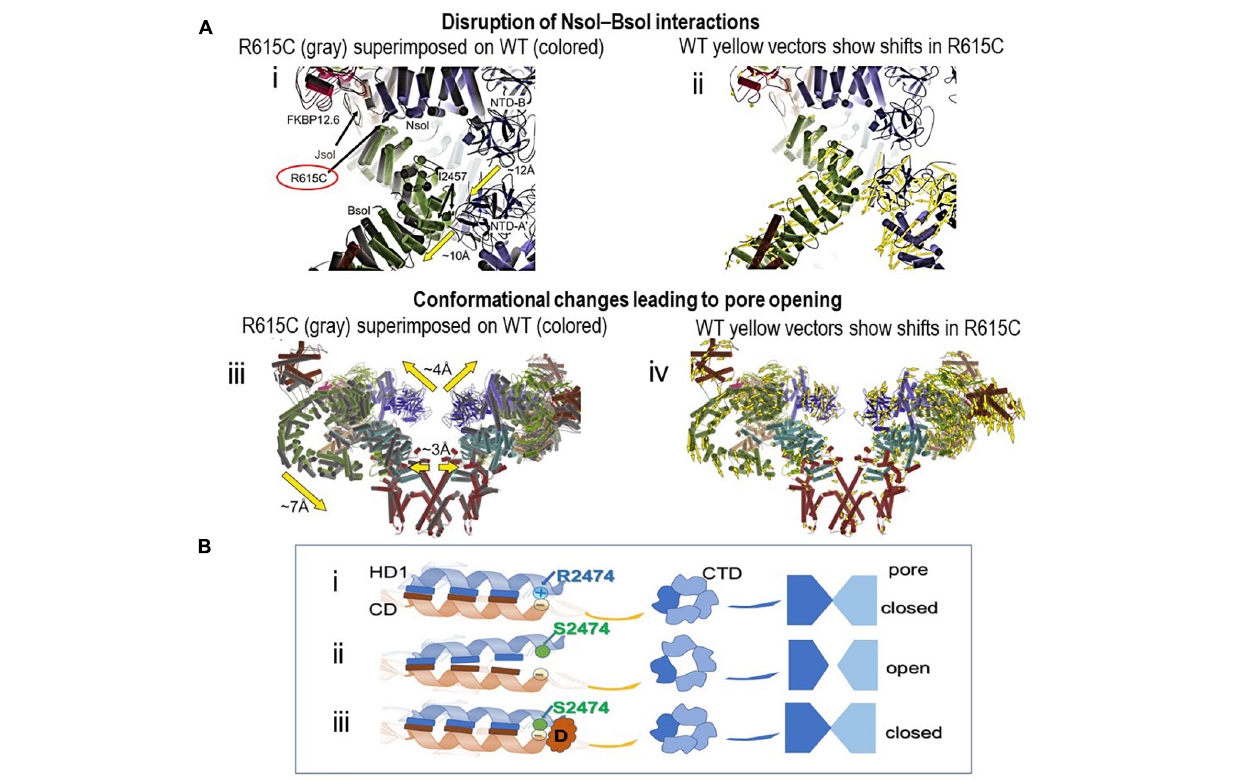
FIGURE 2 | Structural changes associated with RyR mutations. (A) CryoEM images showing that the R615C mutation induces RyR1 channel opening by disrupting interactions between the Nsol and Bsol regions. (i,ii) show local changes around R615 as a result of the mutation, while (iii,iv) illustrate the resulting global changes in the protein. Alpha helices are represented as cylinders. (i) WT (colored) and R615C (gray) structures are superimposed, based on the Nsol region. The location of residue 615 is shown at the junction between the three solenoid regions, the N-terminal solenoid (Nsol, residues 395–630, containing Arg615), junctional solenoid (JSol, residues 1657–2145) and bridging solenoid (Bsol, residues 2146–3613). NTD-A and NTD-B are N-terminal disease hot spot regions. The lower heavy yellow arrow indicates the 10 Å movement of Bsol in the vicinity of residue 2457 resulting from the R615C mutation. This region of Bsol contacts the Nterminal domain A (NTD-A’) of a neighboring subunit. Therefore, as a result of the relative movement of Bsol, the hotspot regions NTD-A and NTD-B no longer form intersubunit interactions, the gap between the N-terminal domains of two neighboring subunits increases and interactions with the N-terminal domains of neighboring subunits are lost, resulting in substantial overall changes in RyR1 structure. (ii) the WT structure only is shown in the same orientation as in (i) . The yellow vectors show shifts > 2 Å in the Bsol helices in R615C relative to WT RyR1. (iii) View of two of the four RyR1 subunits extending from the extreme cytoplasmic to luminal surfaces as in Figure 1A . WT (colored) and R615C (gray) RyR1 structures are superimposed. Global domain movements are indicated by heavy arrows. (iv) WT structure only in the same orientation as in ( iii ). Yellow vectors show shifts > 2 Å throughout the protein in R615C relative to WT RyR1. FKBP12.6 shown in all panels was used as a bait for protein purification. The Figure has been modified from Figure 3 (Woll et al., 2021) under a Creative Commons copyright license CC BY 4.0. Labeling only has been modified. (B) . A cartoon of RyR2 illustrating hypothetical downstream effects of partial unzipping of an interaction between helices in HD1 (in blue) and in the central domain (CD in orange) due to the gain-of-function R2474S mutation (Kobayashi et al., 2010). The mutation likely interrupts an ionic interaction between R2474 and a negatively charged residue in a CD helix. (i) . Interactions between these helices in the WT protein potentially maintain the C-terminal domain (CTD) ring around the pore entrance and the pore itself in the closed conformation. The interacting helices in one subunit only are shown. The residues of interest are shown as circles, the elongated bars indicate unspecified interactions between other residues in the helices that help maintain the interdomain interaction. Inter-subunit interactions between the four CTDs are shown, while only two of the four pore subunits are shown for simplicity. (ii) . The R2474S substitution abolishes the ionic interaction and leads to partial unzipping of the HD1/CD interdomain interaction. This alters the inter-subunit association between the four CTDs, expanding the CTD ring and opening the pore. (iii) . Introduction of a drug (D) that stabilizes the interdomain interaction in the mutant protein restores the normal zipping and returns the CTD ring and the pore to the closed